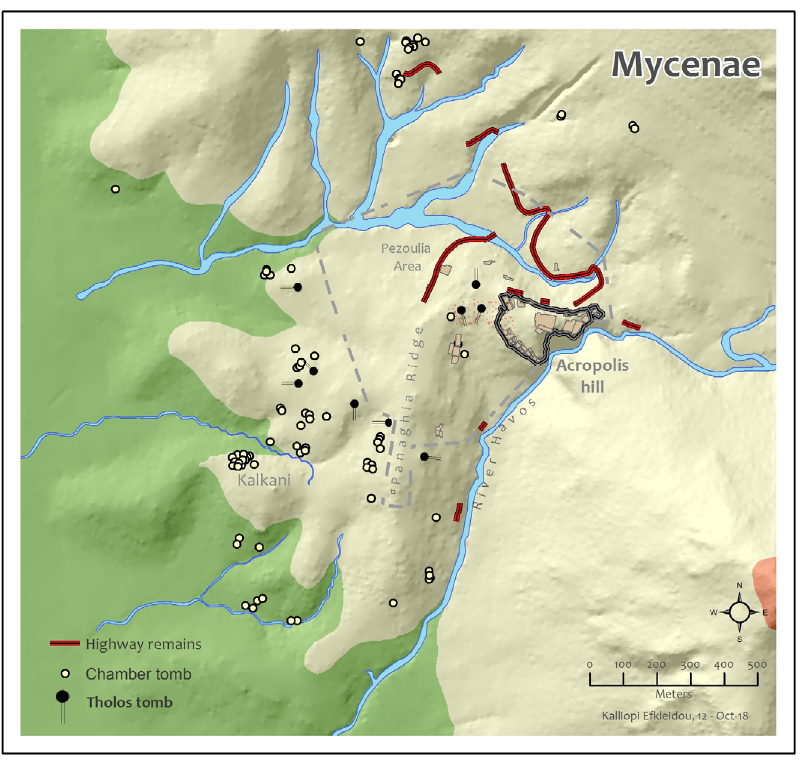
Figure 1. The hinterlands of Mycenae, the chamber tombs and extant Mycenaean road (“highways”)